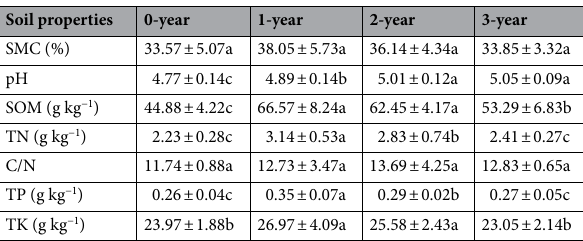
Table 3. Main soil physicochemical properties in different sampling